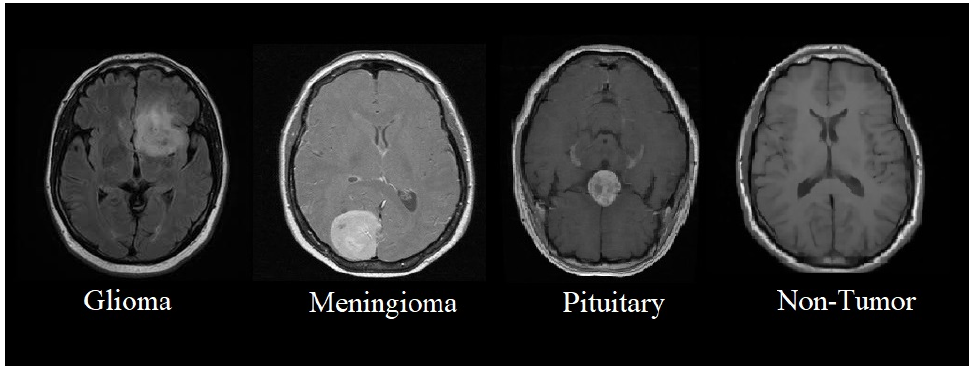
Figure 1. Classification of brain tumors from MRIs.